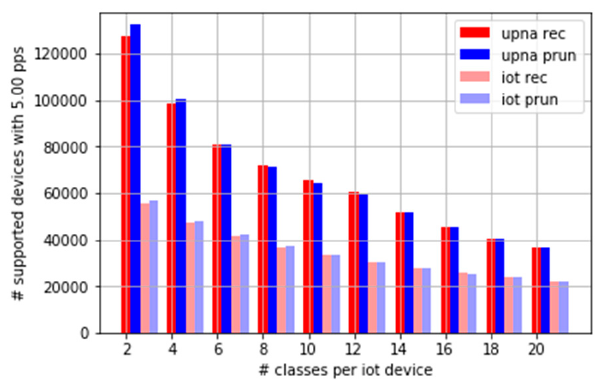
Figure 14. Number of supported devices that generate an average of five pkt/s.